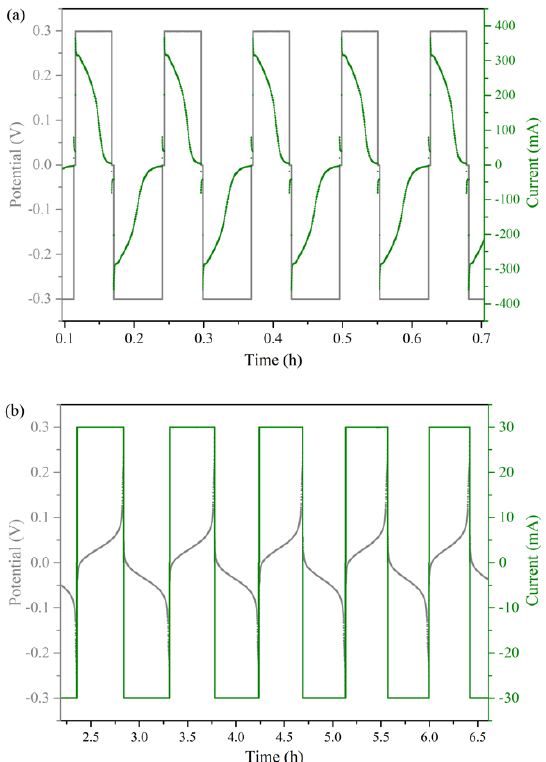
Figure 6. Examples of ( a ) the PS cycling method and ( b ) the GS cycling method.